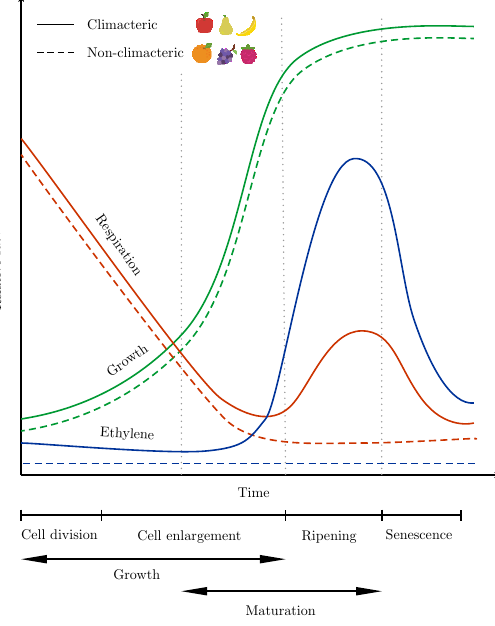
Figure 1. Relative rate of respiration, ethylene production, and growth in climacteric and non-climacteric fruits. Adapted from